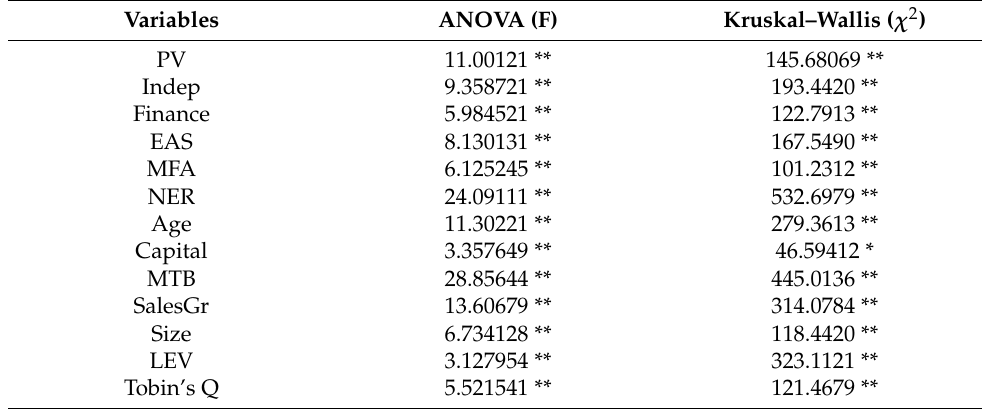
Table 4. ANOVA and Kruskal–Wallis of variables across the Twenty-three industrial